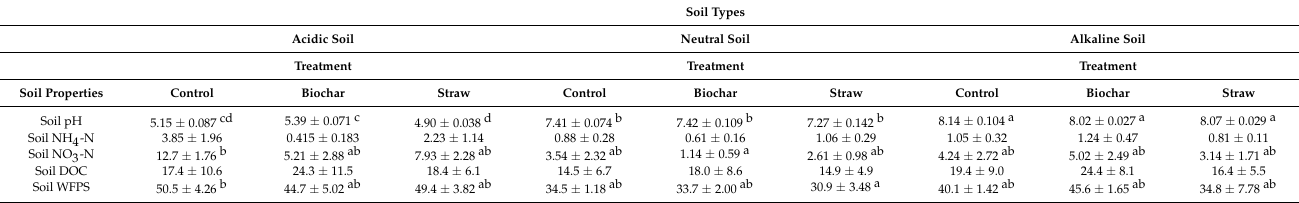
Table 2. Effect of treatments on soil physiochemical parameters on day 57 of the packed soil column experiment (mean ± std